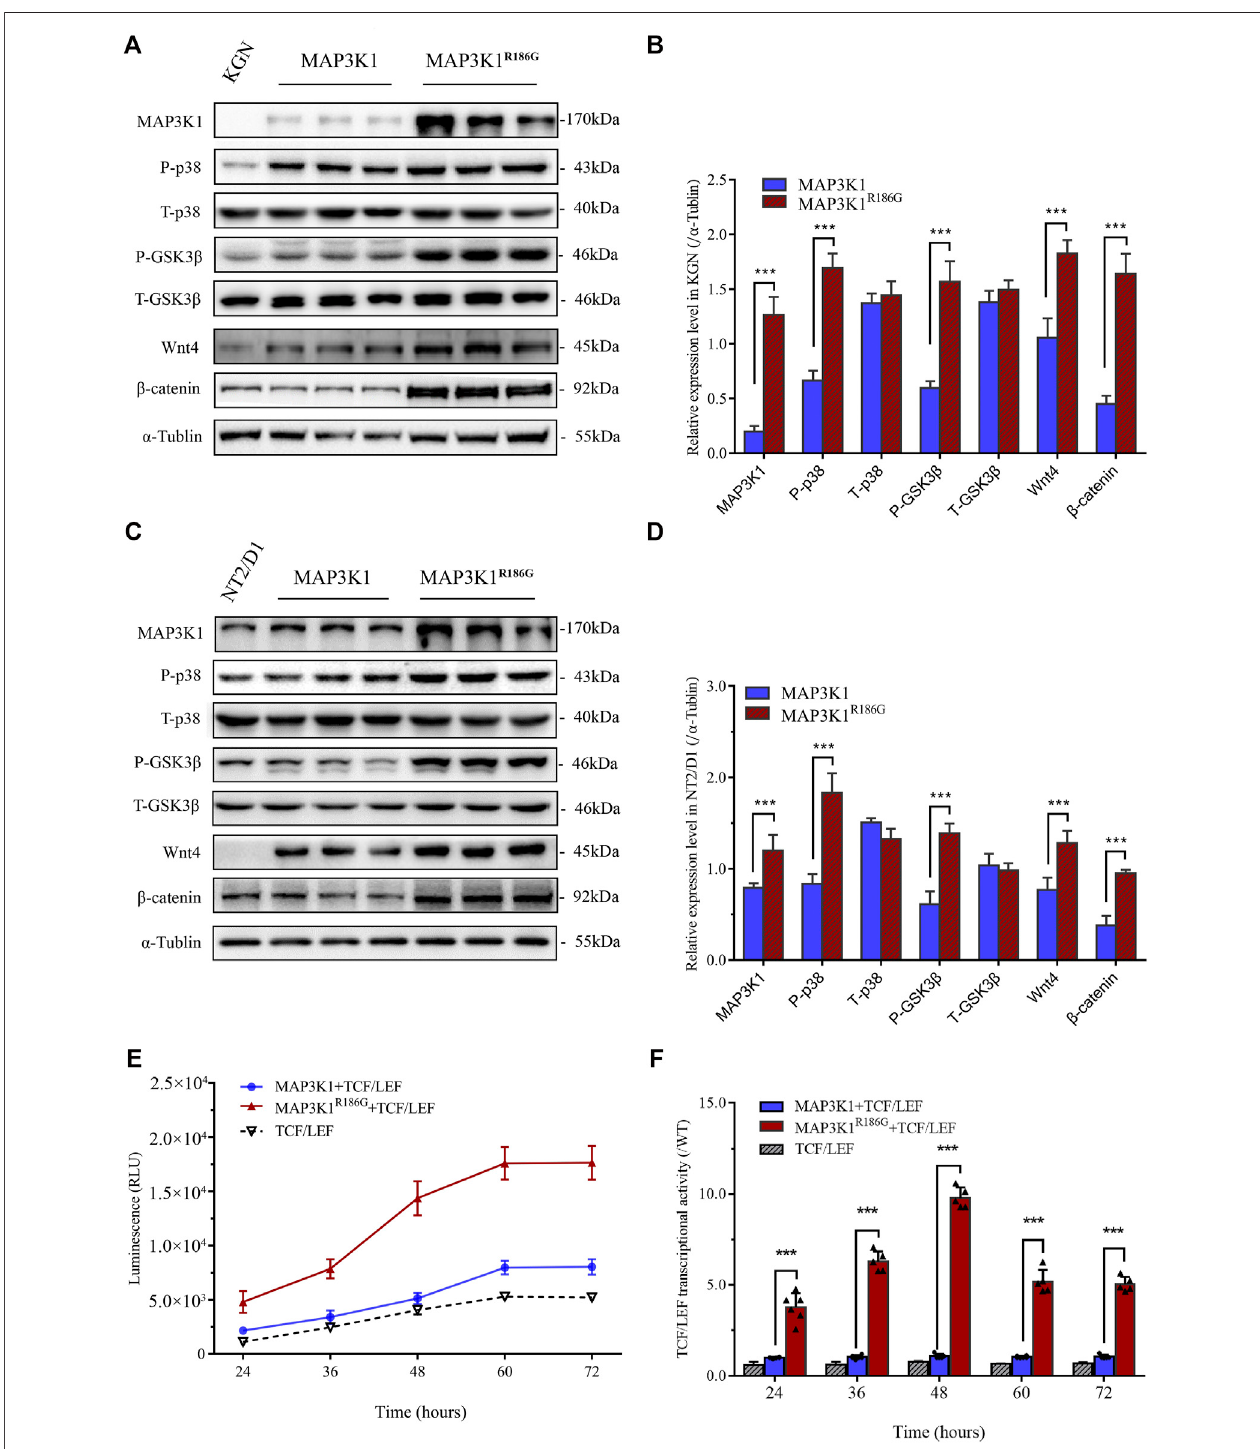
FIGURE 6 | Hyperactivation of Wnt4/ β -catenin signaling. (A – D) NT2D1 or KGN cells transfected with empty vector plasmid or wild-type (MAP3K1) or mutant MAP3K1 (MAP3K1 R186G ) were subjected to Western blotting analysis. (A) Western blotting analysis of phosphorylated P38 (P-p38), total p38 (T-p38), phosphorylated GSK3 β (P-GSK3 β ), total GSK3 β (T-GSK3 β ), Wnt4, and β -catenin in KGN cells. n = 3; mean ± SEM shown; *** p < 0.001 by t -test. (B) Quanti fi ed analysis of Western blottingofP-p38,T-p38,P-GSK3 β ,T-GSK3 β ,Wnt4,and β -catenininKGNcells. (C) WesternblottinganalysisofP-p38,T-p38,P-GSK3 β ,T-GSK3 β ,Wnt4,and β - catenin in NT2/D1 cells. n = 3; mean ± SEM shown; *** p < 0.001 by t -test. (D) Quanti fi ed Western blotting analysis of P-p38, T-p38, P-GSK3 β , T-GSK3 β , Wnt4, and β - catenininNT2/D1cells.Thedatawereexpressedastheratioofproteinslevel(grayvalue)to α -Tubulinproteinlevel(grayvalue). (E,F)